Question: From the figure, is the trend upward or downward?
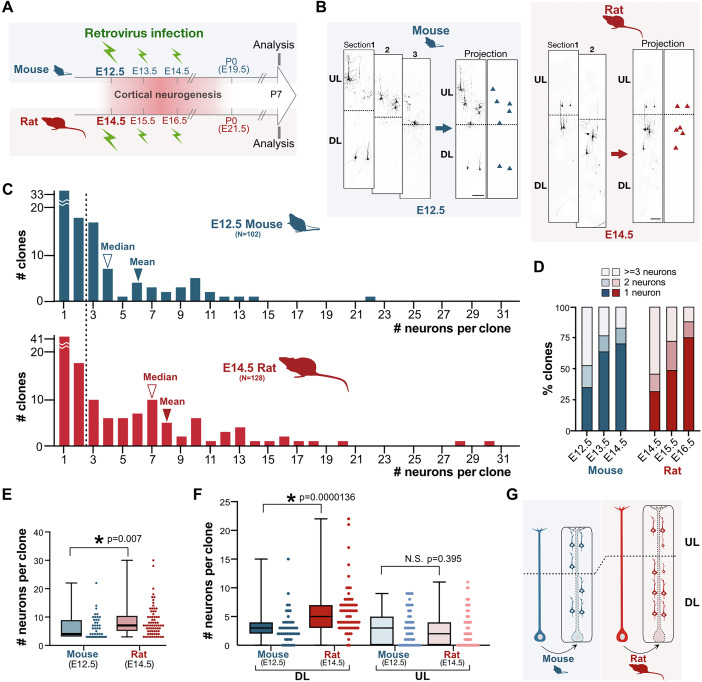
Answer: increasing